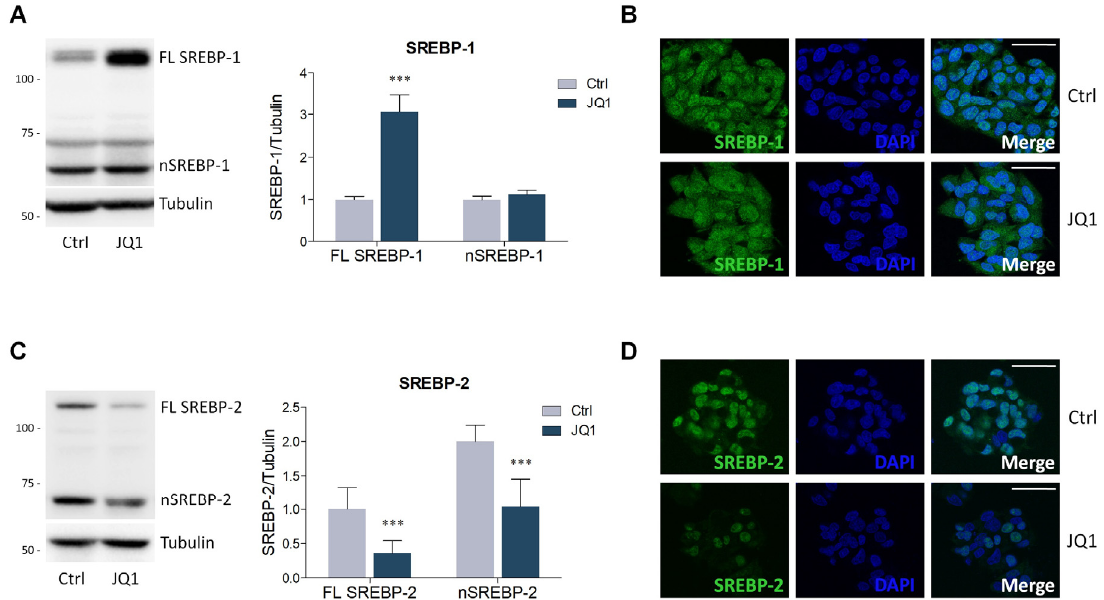
Figure 4. BET inhibition alters sterol regulatory element binding proteins (SREBPs) expression in HepG2 cells treated with JQ1 (0.4 µ M) for 48 hours. ( A ) Representative Western blot (left panel) and densitometric analysis (right panel) of SREBP-1. FL SREBP-1 (Full-length SREBP-1); nSREBP-1 (nuclear SREBP-1). n = 6 independent experiments. Tubulin was employed for control loading. ( B ) SREBP-1 immunofluorescence staining (green) in HepG2 cells. Nuclei were counterstained with DAPI. n = 3 di ff erent experiments. Scale bar: 50 µ m. ( C ) Representative Western blot (left panel) and densitometric analysis (right panel) of SREBP-2. FL SREBP-2 (Full-length SREBP-2); nSREBP-2 (nuclear SREBP-2). n = 6 independent experiments. Tubulin was used as a housekeeping protein. ( D ) Immunofluorescence analysis of SREBP-2 (green). Nuclei were counterstained with DAPI. n = 3 di ff erent experiments. Scale bar: 50 µ m. Data represent means ± SD. Statistical analysis was assessed by using unpaired Student’s t test. *** p < 0.001.